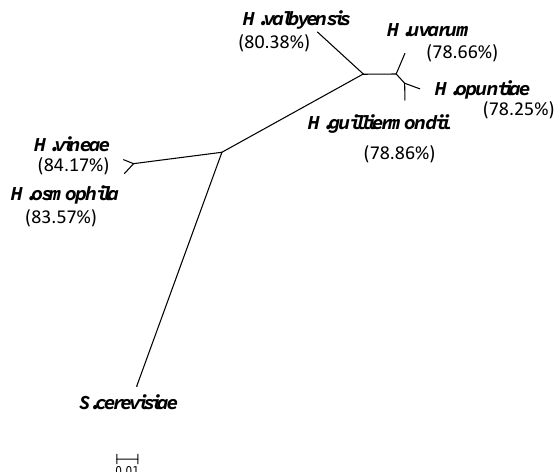
Figure 3. Relative homology of predicted protein sequences from the CDC19 gene for pyruvate kinase activity in genome-sequenced Hanseniaspora strains ( H. vineae T02/19AF; H. osmophila AWRI3579; H. guilliermondii UTAD222; H. opuntiae AWRI3578; H. valbyensis NRRL Y-1626; H. uvarum AWRI3580;